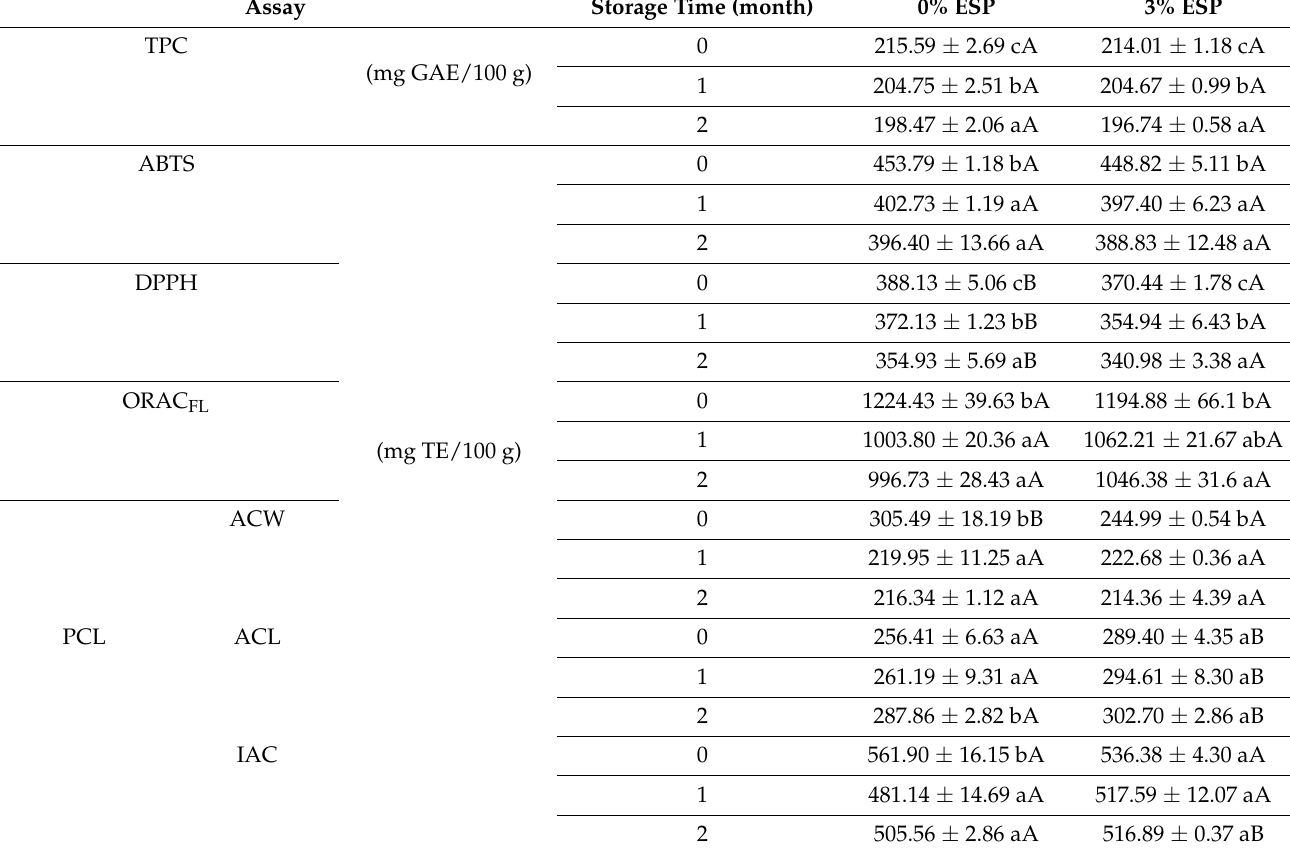
Table 4. Total phenolics content and antioxidative activity of fresh and stored gingerbread